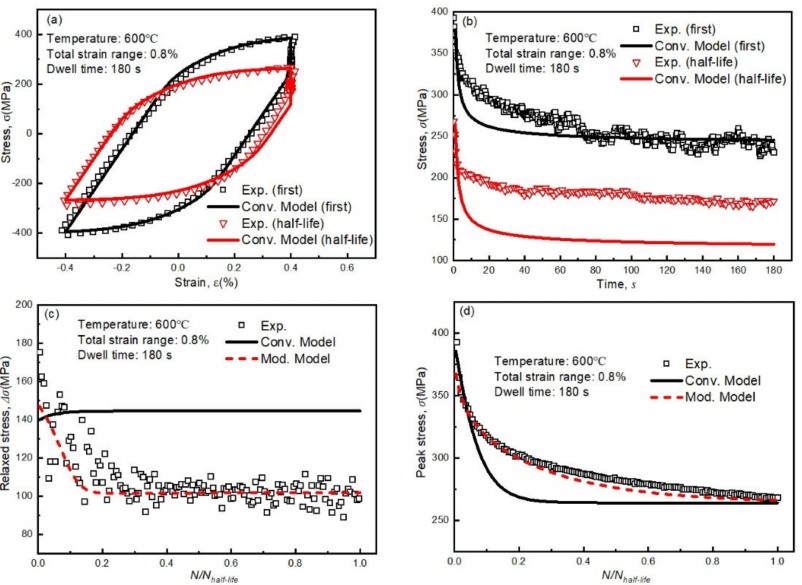
Figure 8. Comparison of simulated and experimental responses for 0.8% total strain range with 180 s tensile dwell time at 600 ◦ C, ( a ) hysteresis loops at the first and half-life cycles; ( b ) stress relaxation during dwell time at the first and half-life cycles; ( c ) relaxed stress evolution with cycle; ( d ) peak tensile stress evolution with